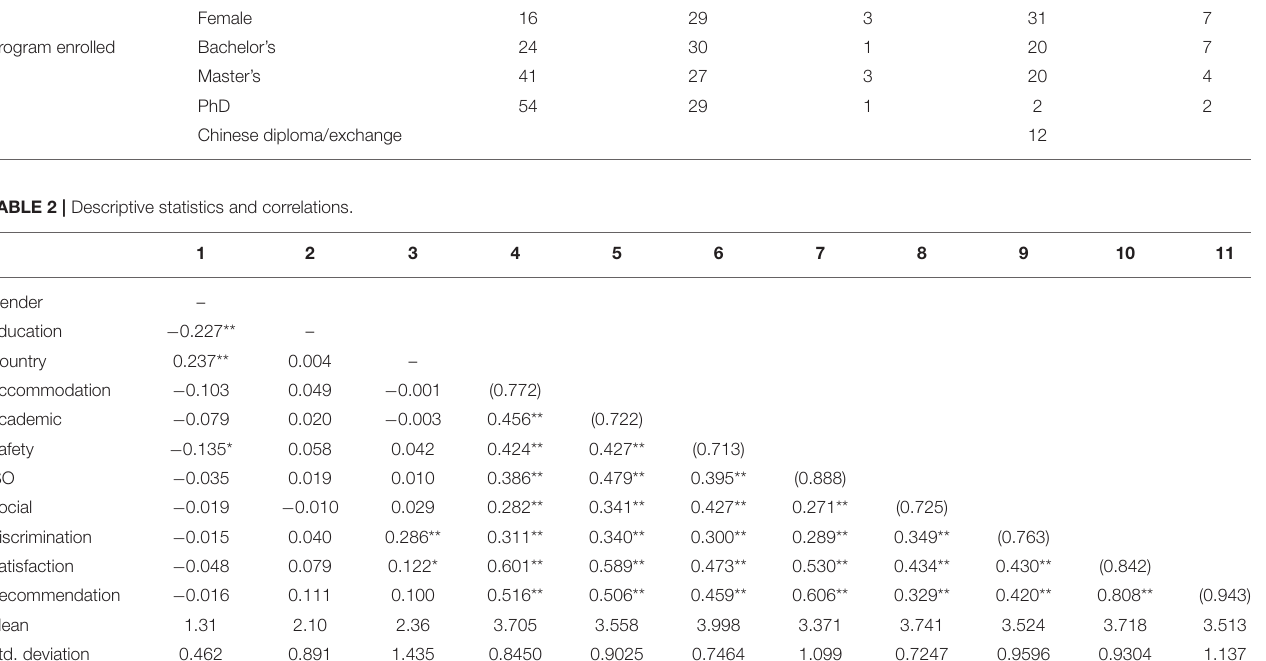
TABLE 1 | Demographics of respondents.